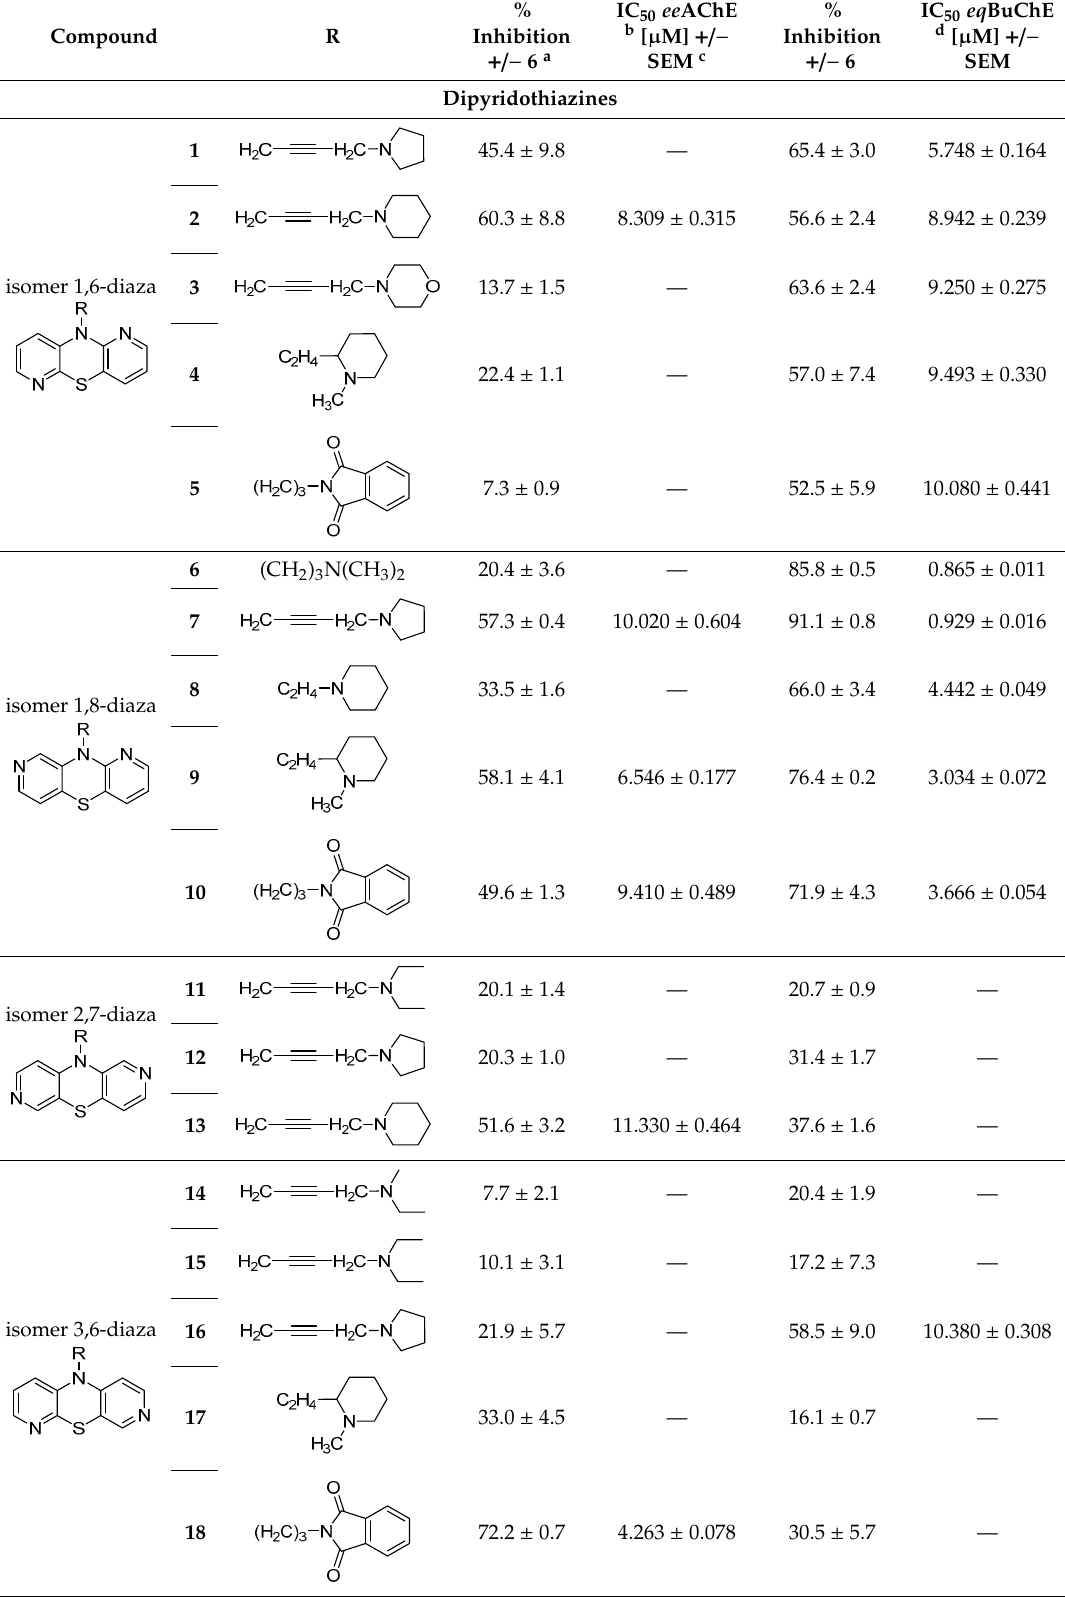
isomer 1,6-diaza